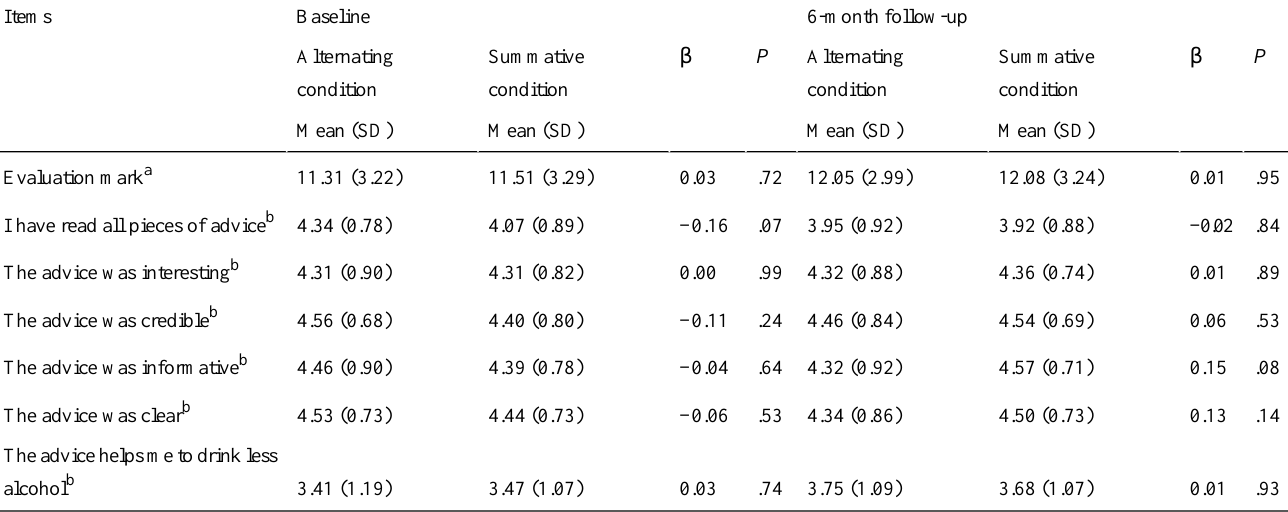
Table 4. Differences between the 2 experimental subgroups (alternating condition: n=59; summative condition: n=72) regarding the evaluation items about appreciation of the